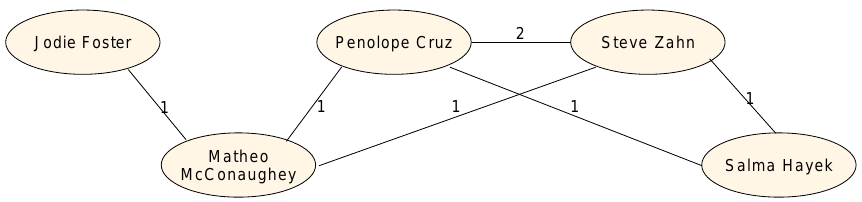
Figure 2. Extracted social network of co-acting among